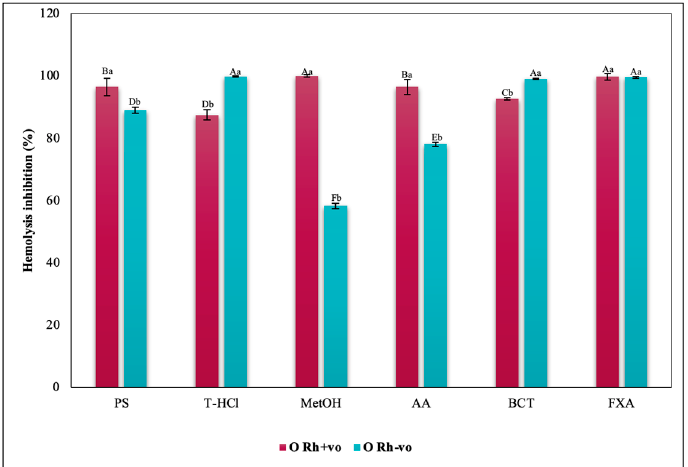
Figure 11. Inhibitory effect of hypotonicity-induced hemolysis of P. cruentum extracts on human erythrocytes with different RhD (positive and negative) of O blood group. Different letters represent significant differences in the means between treatments and groups ( p ≤ 0.001). Capital letters represent a two-way ANOVA. Lowercase letters represent a univariate ANOVA between the extracts. PS, extract of physiological solution; T-HCl, 0.5 M Tris-HCl extract; MetOH, 99% methanol extract.